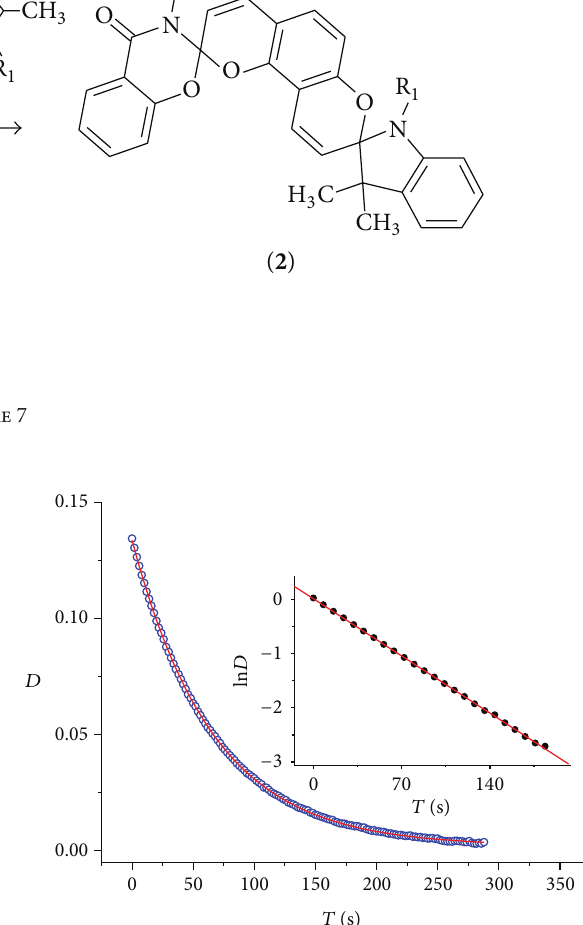
Figure 8: UV absorption spectrum of a bis-spiropyran ( 2a ) in toluene solution under continuous irradiation with unfiltered light. ( [ c ] = 3.19 × 10 −5 M; 𝑇 = 293 ∘ K; curves are recorded with 15s interval).